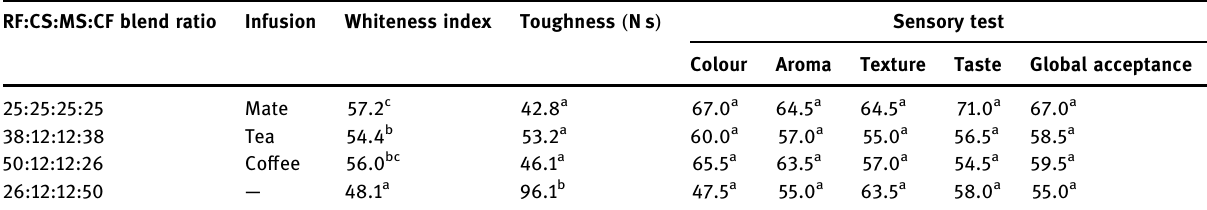
Table 2: Colour ( whiteness index ) , texture ( toughness ) , and results of the sensory test of gluten - free biscuits prepared from four blends of rice fl our ( RF ) , cassava starch ( CS ) , maize starch ( MS ) , and chickpea fl our ( CF ) with